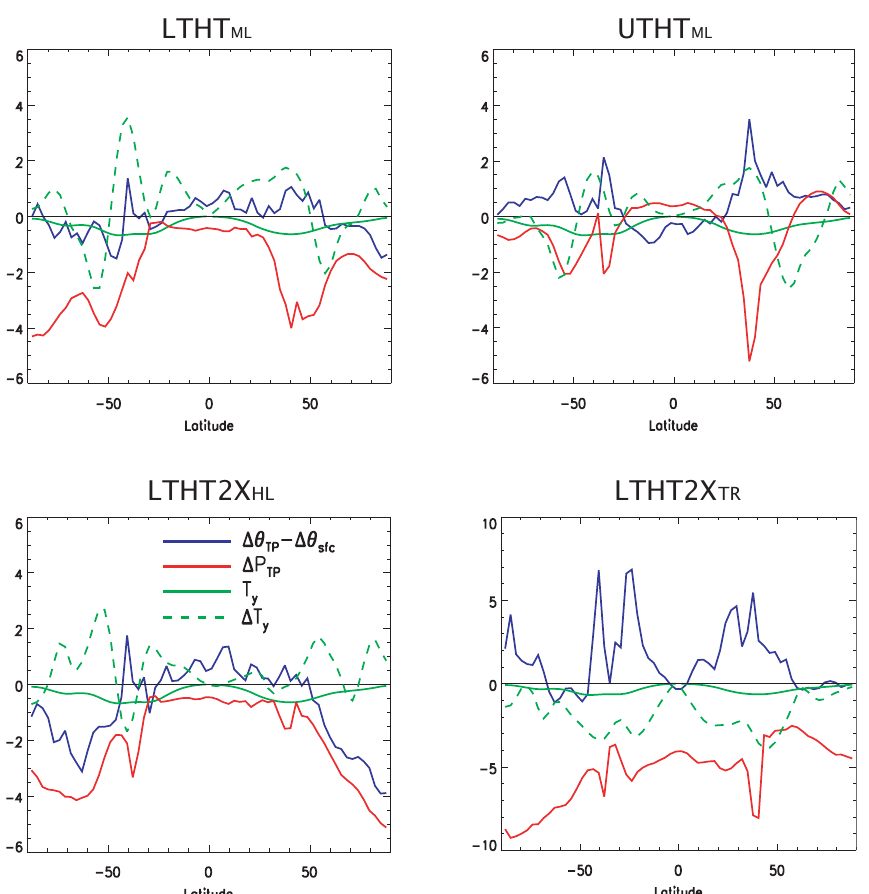
Fig. 8. Annual mean gross dry static stability change (blue; 1θ TP − 1θ sfc ), tropopause pressure change (red; 1P TP ), climatological baro- clinicity at 500hPa (green solid; T y ) and the corresponding response (green dashed; 1T y ) for (top left) LTHT ML , (top right) UTHT ML , (bottom left) LTHT2x HL and (bottom right) LTHT2x TR . Units are K, hPa, K km − 1 10 − 4 and K km − 1 10 − 2 ,